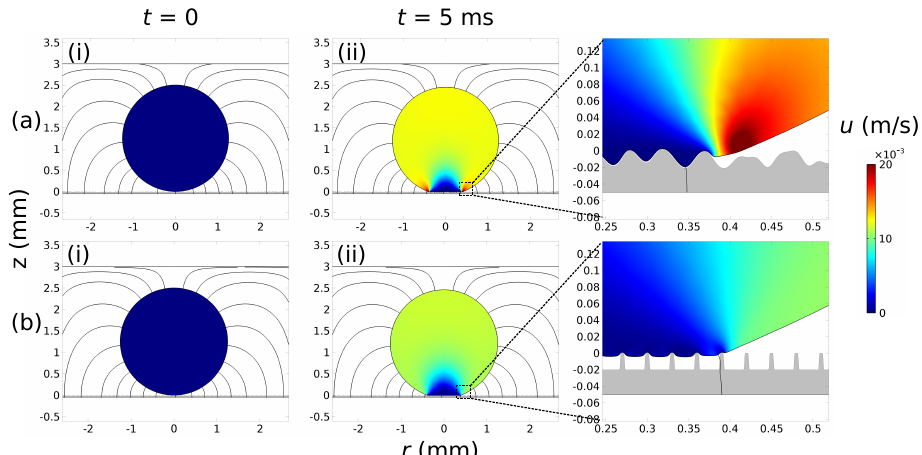
Figure 2. Visualization of the velocity magnitude (at t = 0 and t = 5 ms) of a glycerin droplet on two different structured solid dielectrics: ( a ) arbitrary-structured and ( b ) stripe-structured ( θ Y = 114 o , d h = 20 µ m and d = 50 µ m for both solid dielectric cases). The electric field lines are also depicted (a voltage of 220 V, or η = 0.25, is applied in both cases). As observed in the inset, a Wenzel state is observed at the arbitrary-structured topography ( a ) whereas a Cassie-Baxter state is accommodated in stripe-structured topography ( b ). The disjoining pressure parameters we use are, according our previous work (see [14–16]): C 1 = 12, C 2 = 10, σ = 9 × 10 − 3 and (cid:101) = 8 × 10 − 3 (resulting in δ min = 1.25